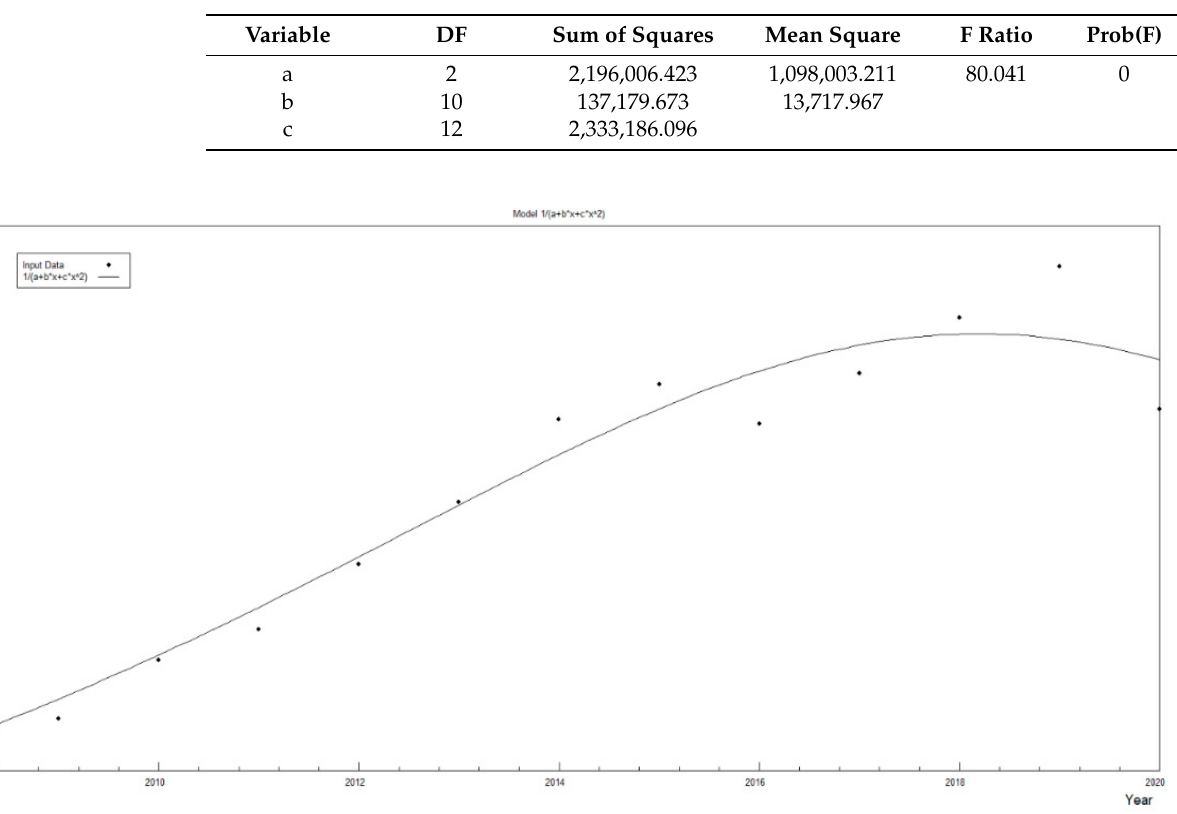
Table 7. Values of the coefficients of the mathematical model for a 99% confidence interval of the function. Variable